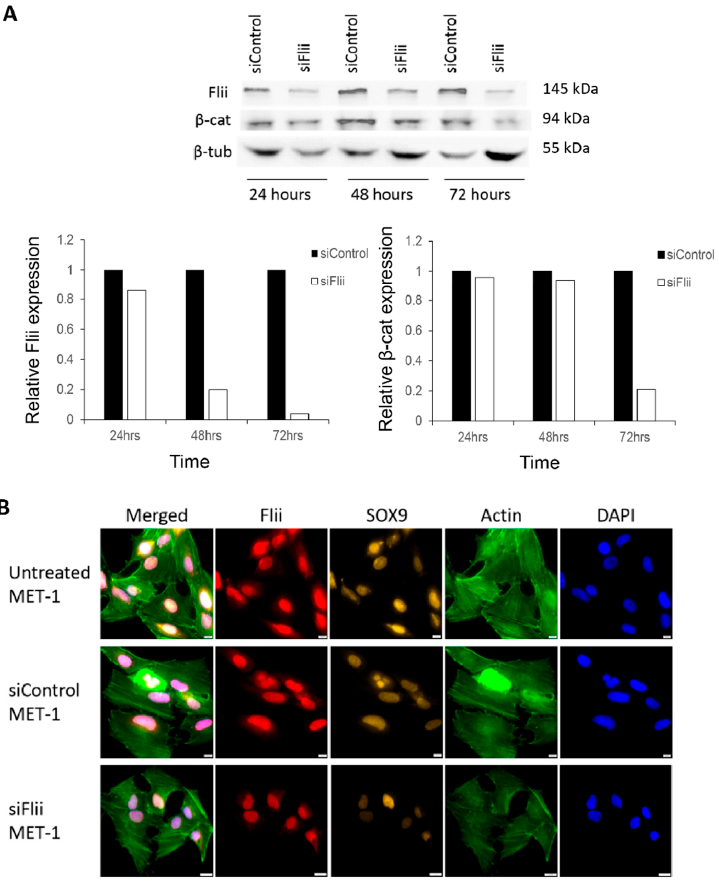
Figure 2. Knockdown of Flii in human cSCC cell line reduces SOX9 but not β -catenin levels. ( A ) Western blot analysis and graphical quantification of Flii, β -catenin and β -tubulin protein levels in MET-1 cells treated with siControl and siFlii at 24, 48 and 72 h intervals. Samples are pooled from three independent technical repeats. ( B ) Immunocytochemistry of Flii (red), SOX9 (yellow), Actin (green) and DAPI (blue) in MET-1 cells following Flii knockdown. Scale bars, 5 μ m.